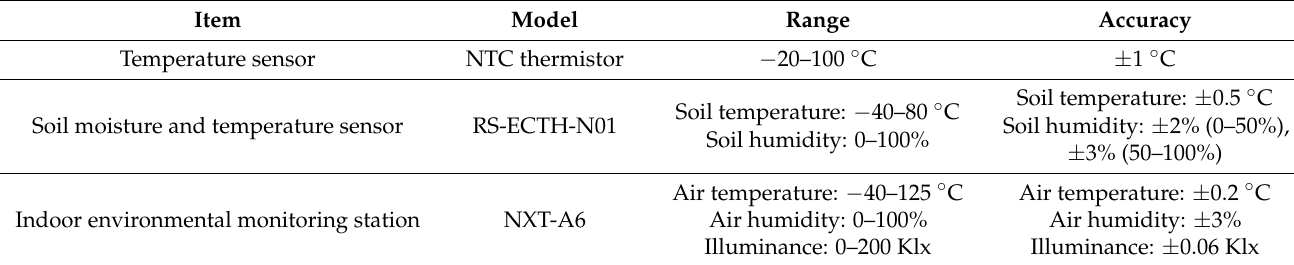
Table 2. Summary of the experimental